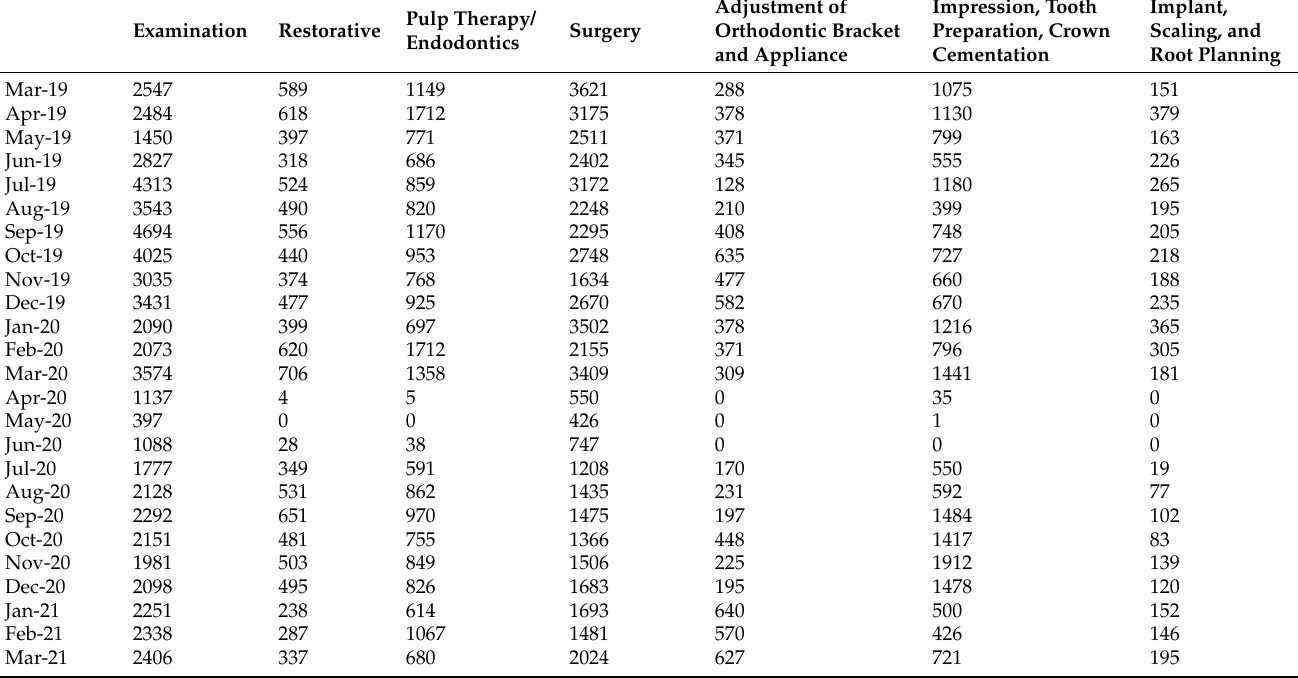
Table 4. Type of procedure performed by month from March 2019 to March